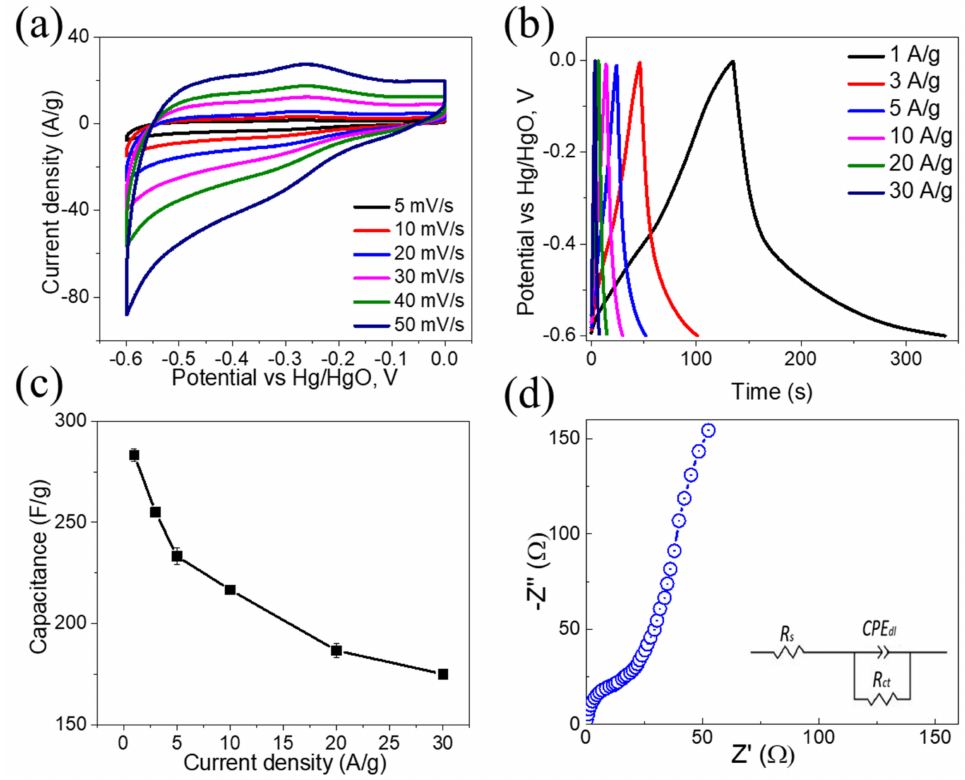
Figure 5. Electrochemical measurements of a TiO 2 /PVDF membrane electrode in the aqueous electrolyte; ( a ) CV profiles at different scan rates; ( b ) GCD profiles at different current densities; ( c ) Specific capacitance versus current density; ( d ) Nyquist